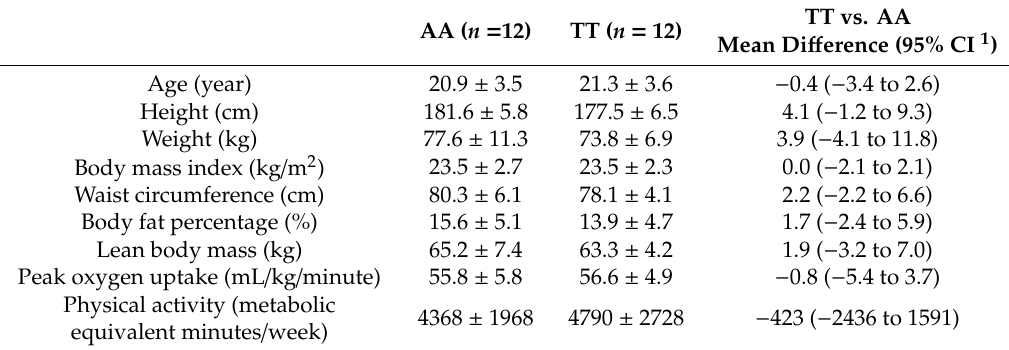
Table 1. Descriptive characteristics of the AAs and